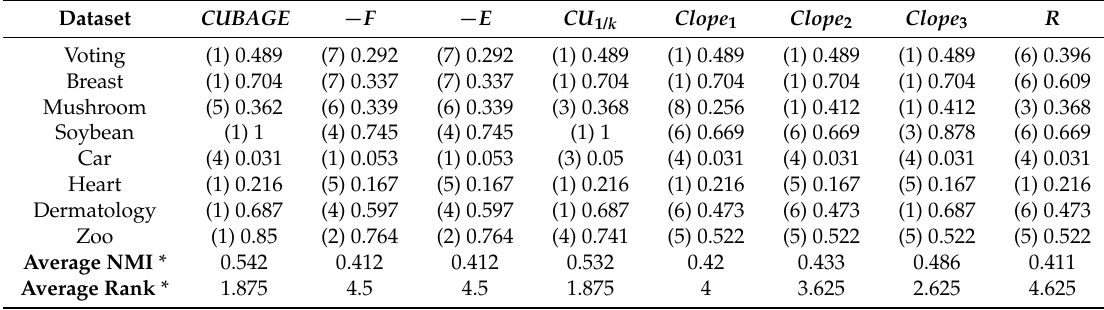
Table 6. Normalized mutual information (NMI) values of the hierarchical partitions chosen from layers 2–10 by each internal CVI.